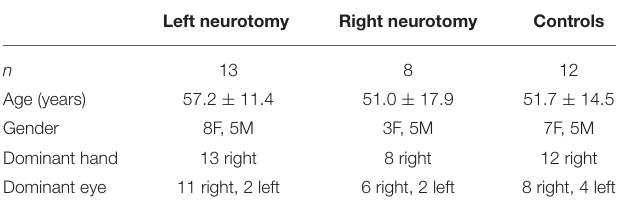
TABLE 1 | Demographic data of the participants. TABLE 2 | Clinical data of patients.